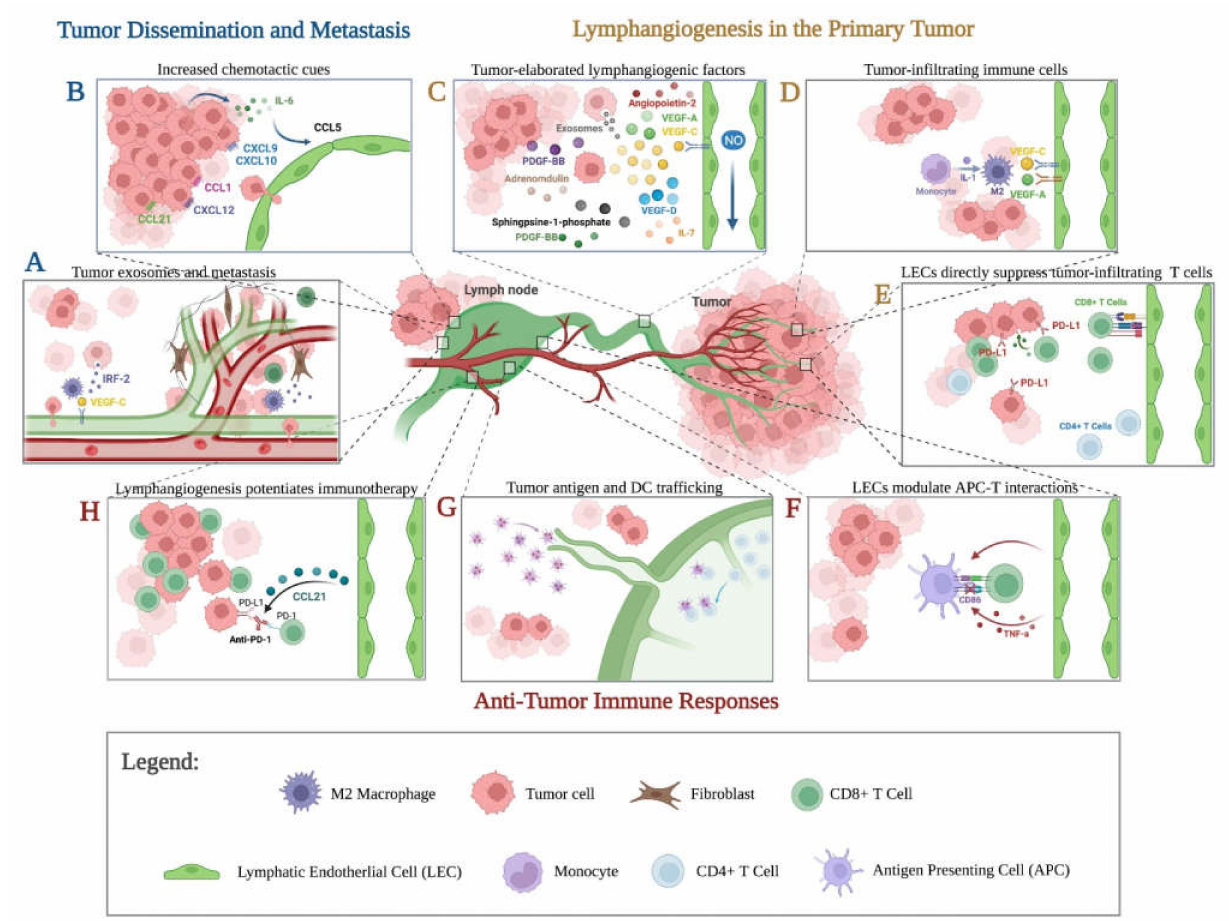
Figure 1. The role of lymphatics in tumor progression and immunomodulation. ( A ) Tumor invasion of nodal lymphatics results in lymphatic spread while invasion of lymph node blood vessels leads to systemic dissemination. Tumor exosome IRF-2 increases lymph node lymphangiogenesis by inducing the secretion of VEGF-C by nodal macrophages. ( B ) Various chemotactic cues in tumor-draining lymph nodes promote tumor entry and colonization of the lymph node. ( C ) Tumor-elaborated lym- phangiogenic factors mediate intratumoral and peritumoral lymphatic expansion. VEGF-C acts on its receptors VEGFR-2/3 to induce tumoral lymphangiogenesis through the activation of endothelial- derived nitric oxide synthase (eNOS) by LECs, leading to increased lymphatic flow around the tumor and facilitating lymphatic metastasis. Additional tumor-elaborated lymphangiogenic factors include VEGF-D, VEGF-A, PDGF-BB, angiopoietin-2, sphingosine-1-phosphate, adrenomedullin, IL-7,